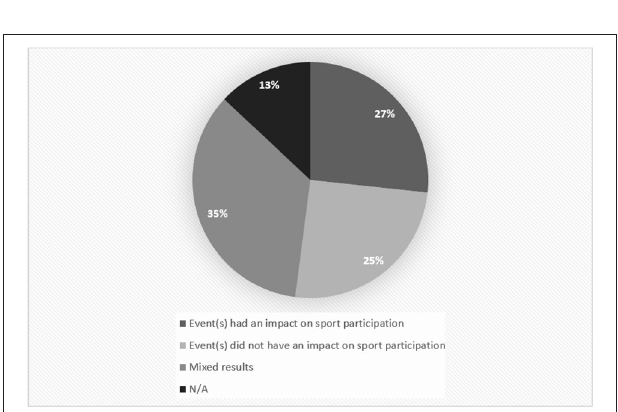
FIGURE 5 | Research